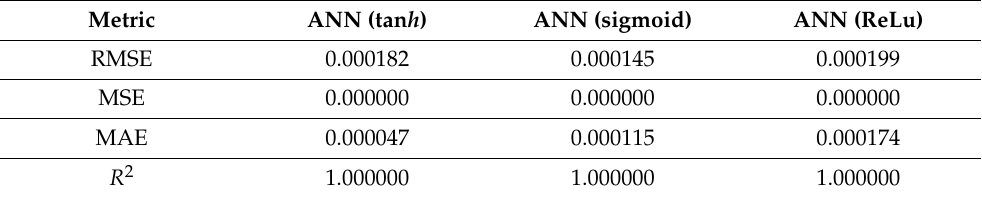
Table 8. Performance evaluation of the ANN model with different activation functions for the target k rop .